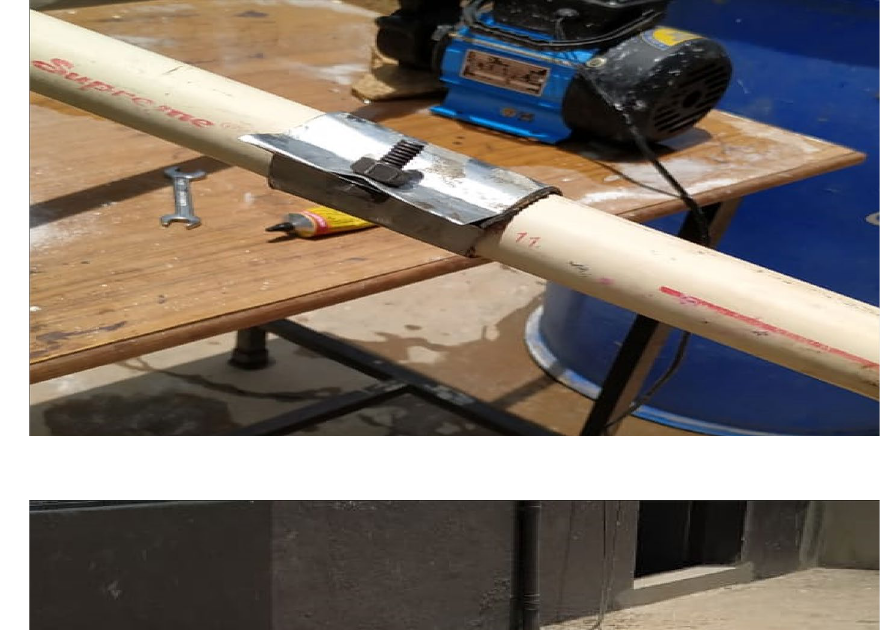
Fig. 5 Clamping of pipe using aluminum alloy clamps